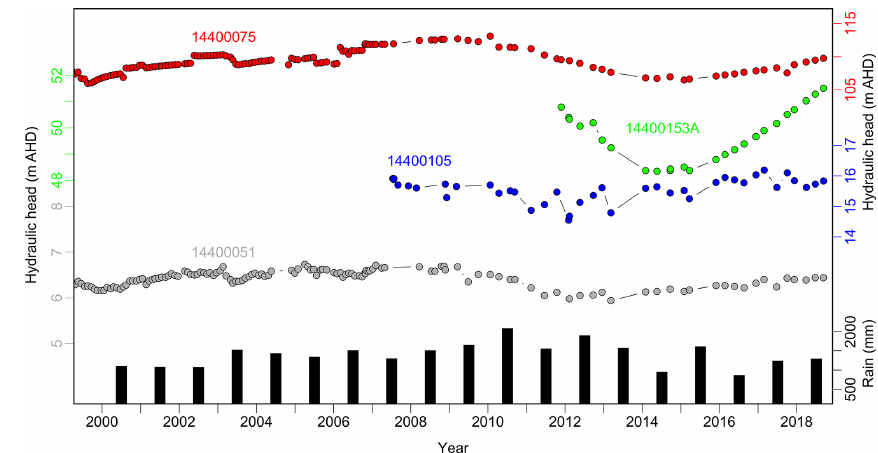
Figure 2. Hydraulic heads (metres Australian Height Datum, m AHD) for four selected groundwater bores, 14400051, 14400075, 14400105 and 14400153A, and yearly rainfall for the period from 2000 to